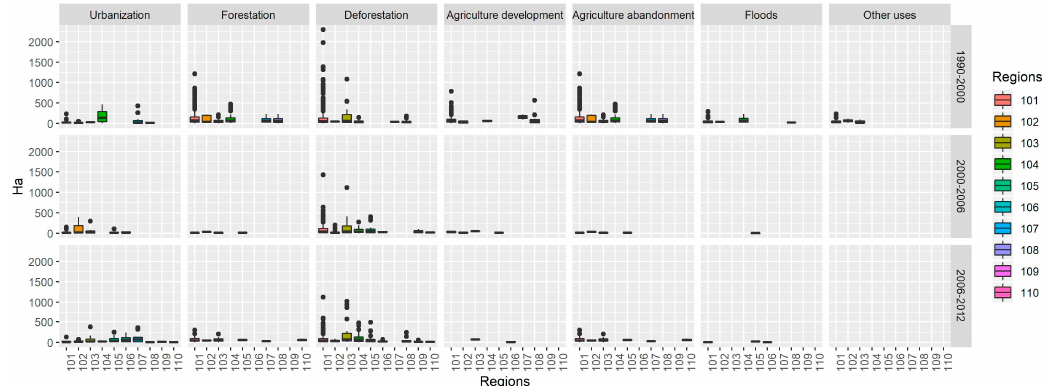
Figure 5. Variation of transitional dynamics by classes and study period. Regions as shown in Figure 1.